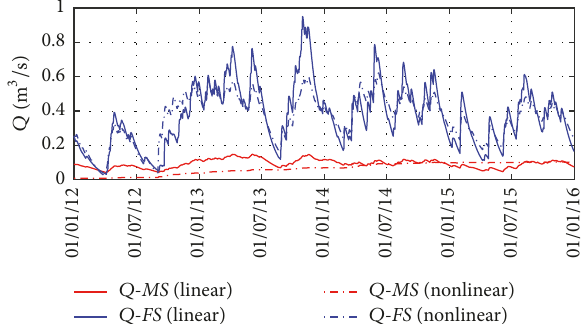
Figure 8: Flow distribution between the diffuse ( 𝑀 – matrix) and thefracture (𝐹)